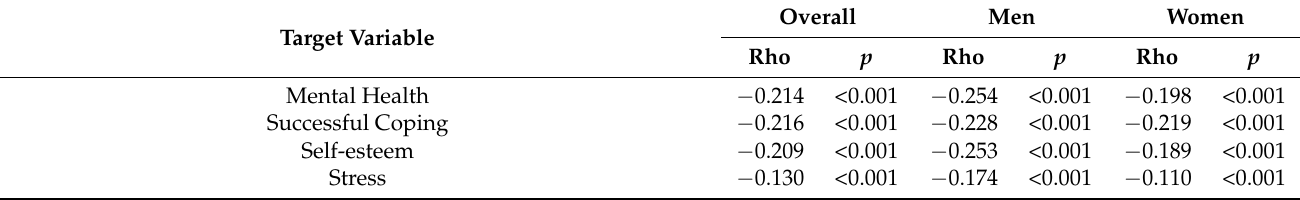
Table 3. Correlations between PAL and the Goldberg General Health Questionnaire (GHQ-12) dimensions in Spanish adults with psychological distress, according to the ENSE